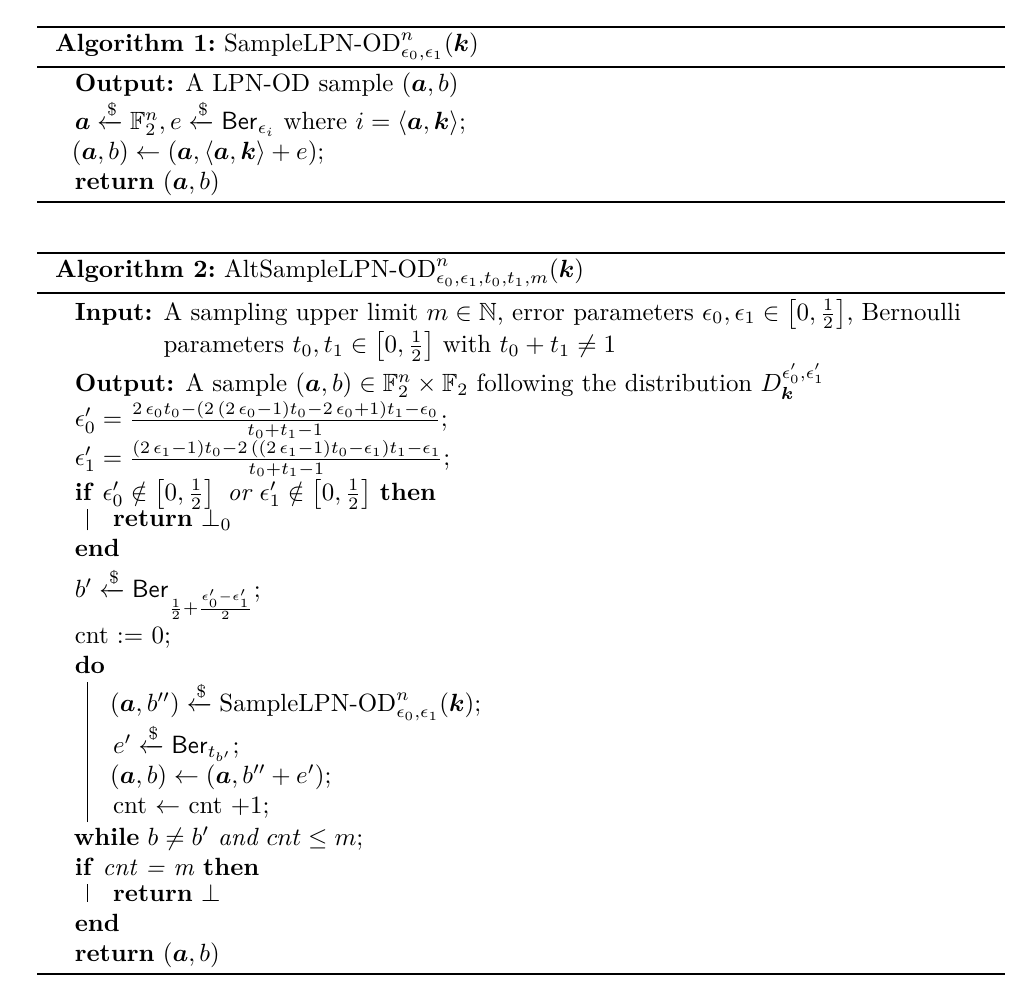
Algorithm 1: SampleLPN-OD n